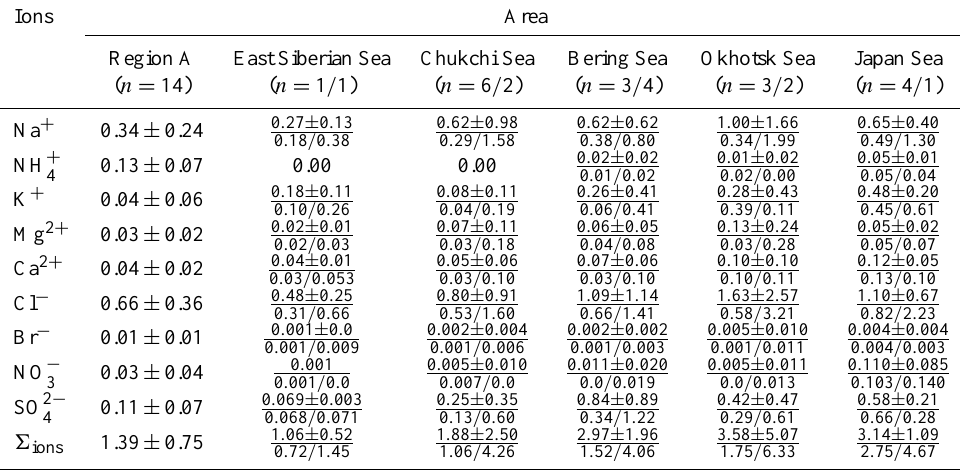
Table 6. Average characteristics of ion composition of atmospheric aerosol on the route of RV Akademik Fedorov and Professor Khljustin (the numerator indicates the average ion content in µgm − 3 and standard deviations; the denominator indicates the average values on the forward and return routes; n is the number of samples; and P ions is the summed ion content). Ions